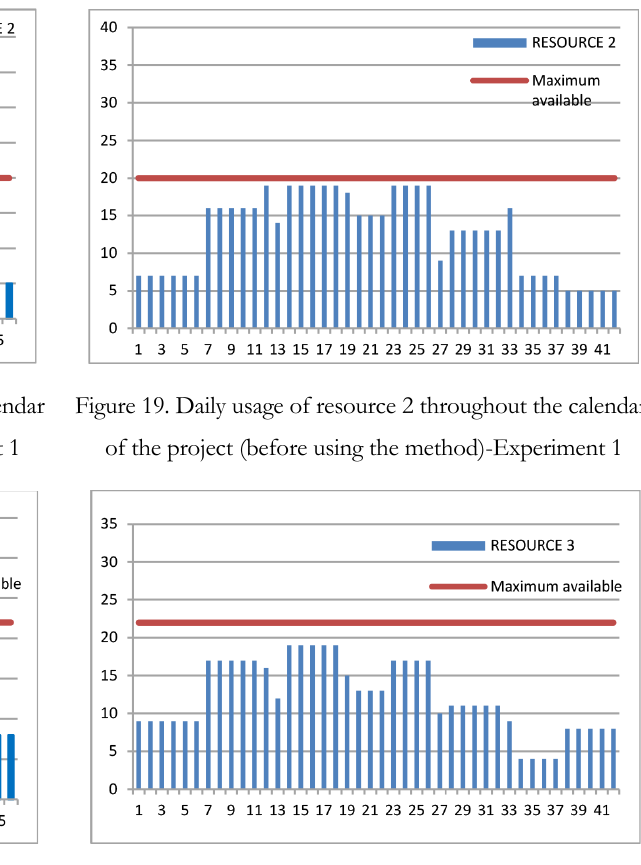
Figure 20. Daily usage of resource 3 throughout the calendar of the project (before using the method)-Experiment 1